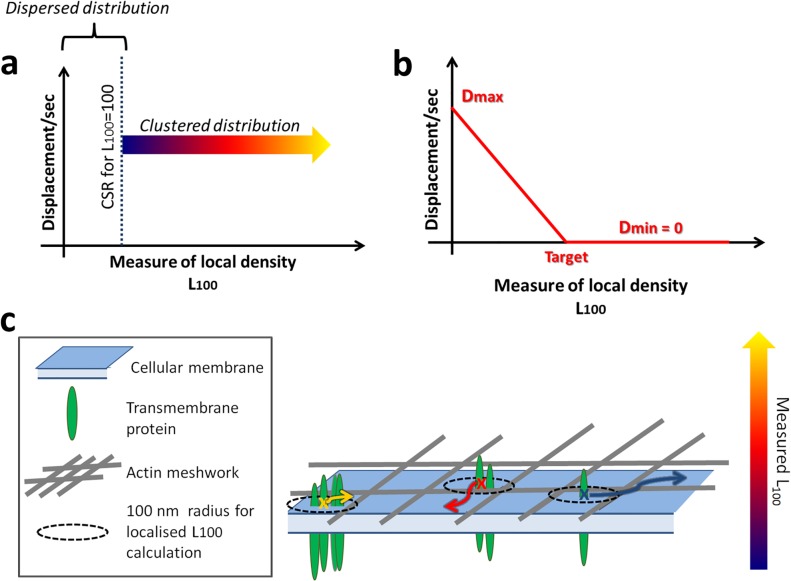
Defining the model.a. Defining the “desire for clustering” as a relation between the L100 value attributed to each molecule and its displacement per second. b. Displacement profile applied to each molecule in the Standard Condition. c. General model in which the displacement per second of each molecule (colour coded arrows) depends on the local level of clustering (i.e. the number of molecules encircled).